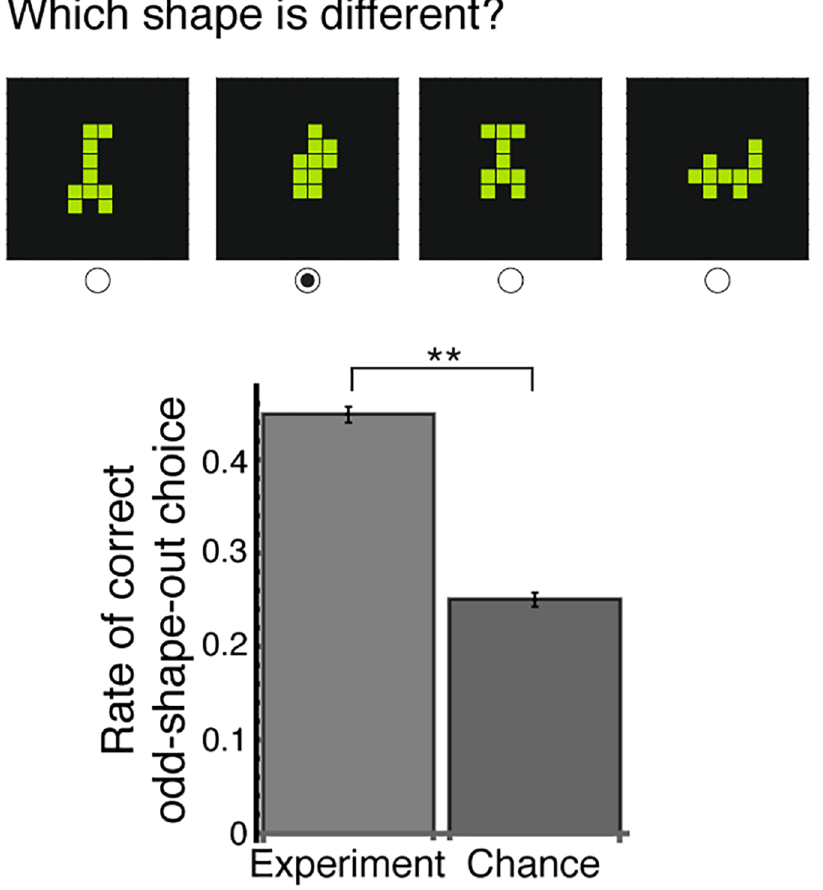
Fig 3. Shapes found in an exploitation phase are perceived as similar. Participants who did not play the creative foraginggame chose the odd-one-out among four shapes, three from the same exploitation phase and one from a different exploitation phase found by the same player. Participants chose the outlier twice as often as by chance. Means and std (computedusing bootstrapping) are shown ( p < 0.0001, see Section D in S1